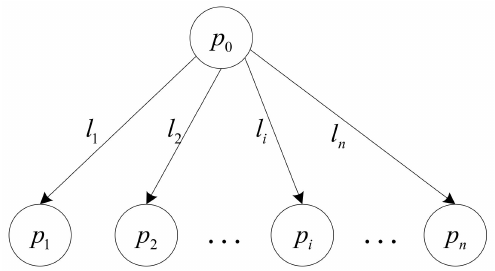
Figure 1. Heterogenous single-level tree network topology. Table 1. Notations and their